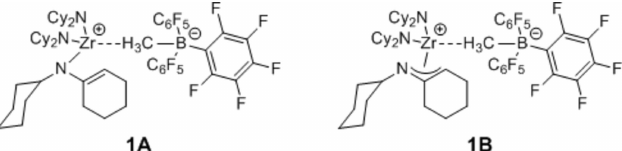
Figure 1 (cid:4) 1 -Enamido ( 1A ) versus (cid:5) 3 -azaallyl ( 1B ) bonding modes found in azaallyl